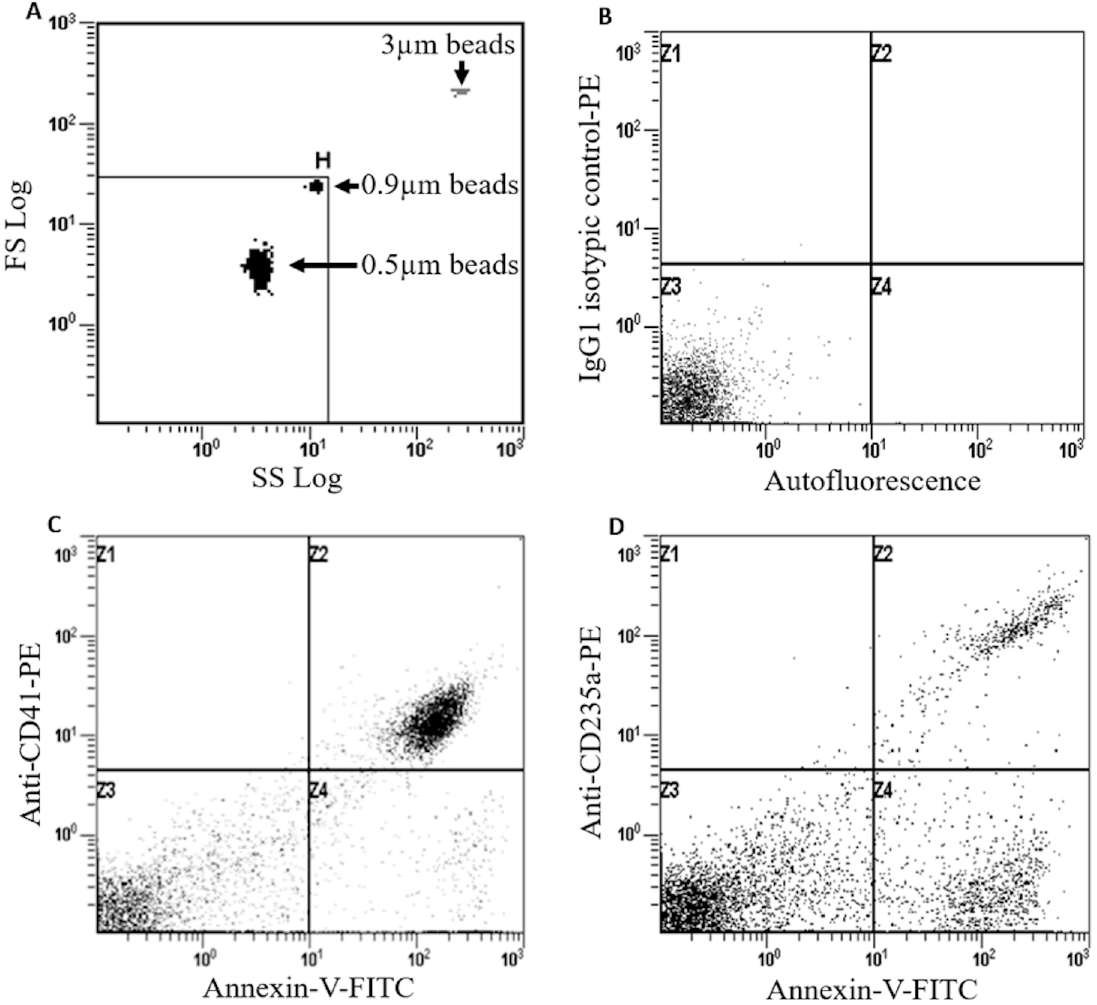
Fig 1. MP characterization by flow cytometry. A : Acquisitiongate (H) was based on forward- and side-scatter values of 0.9 mm-largecalibrationbeads; B : autofluorescence was determined using isotopic control (IgG-PE); C : platelet-derived MPs or D : erythrocyte-derived MPs were labelledwith FITC-annexin-V(FL1) and PE-conjugated monoclonal antibodiesdirected against CD41 or CD235a, respectively.